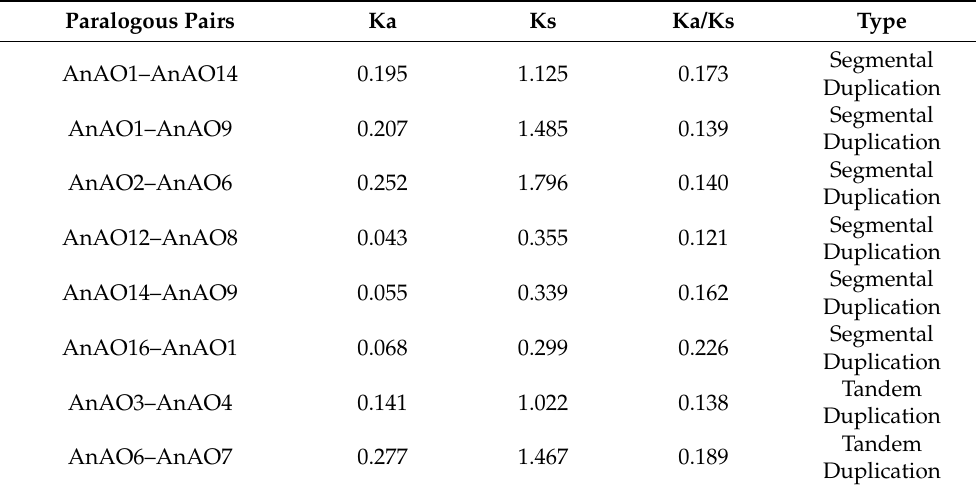
Table 2. Analysis of evolutionary selection pressure on the AO gene family of A. nanus